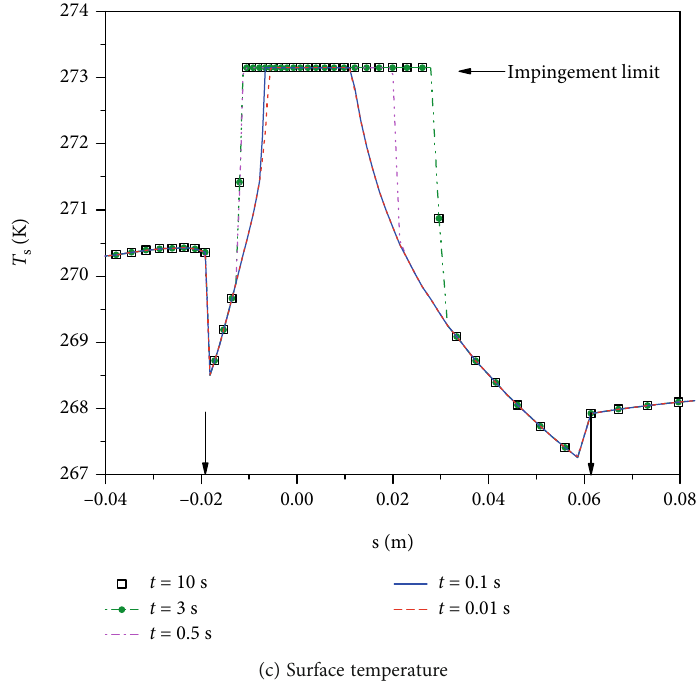
Figure 5: Icing results at di ff erent times for